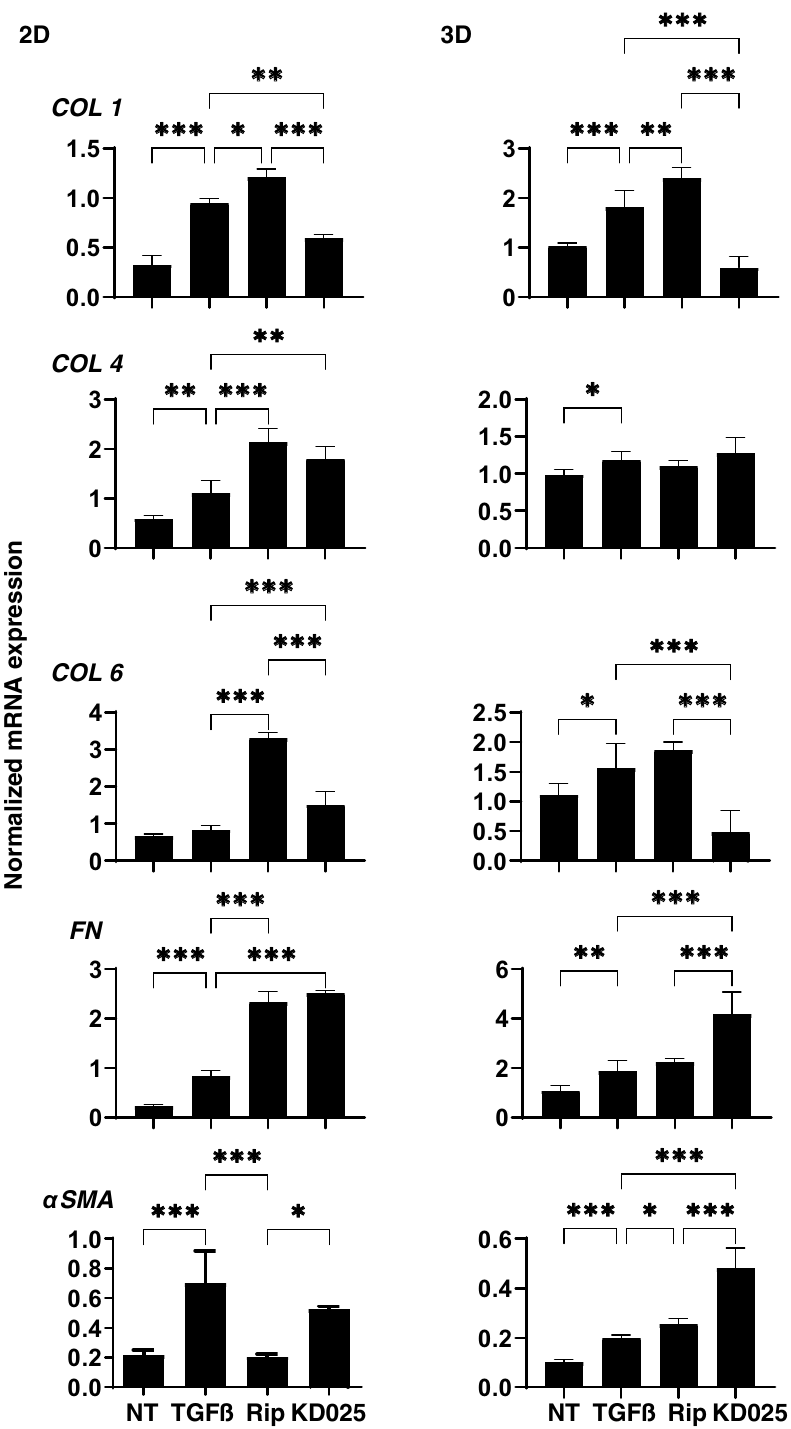
Figure 4. mRNA expression of ECM in 2D and 3D cultured HTM cells. At Day 6, HTM 2D cells and 3D sphenoids (control) and those treated by 5 ng/ml TGFβ2 in the absence or presence of 10 μM ripasudil (Rip) or KD025 were subjected to qPCR analysis to estimate the expression of mRNA in ECMs ( COL1 , COL4 , COL6 , FN and aSMA ). All experiments were performed in duplicate using 15–20 freshly prepared 3D HTM sphenoids in each experimental condition. Data are presented as the arithmetic mean ± standard error of the mean (SEM). * P < 0.05, ** P < 0.01, *** P < 0.005 (ANOVA followed by a Tukey’s multiple comparison